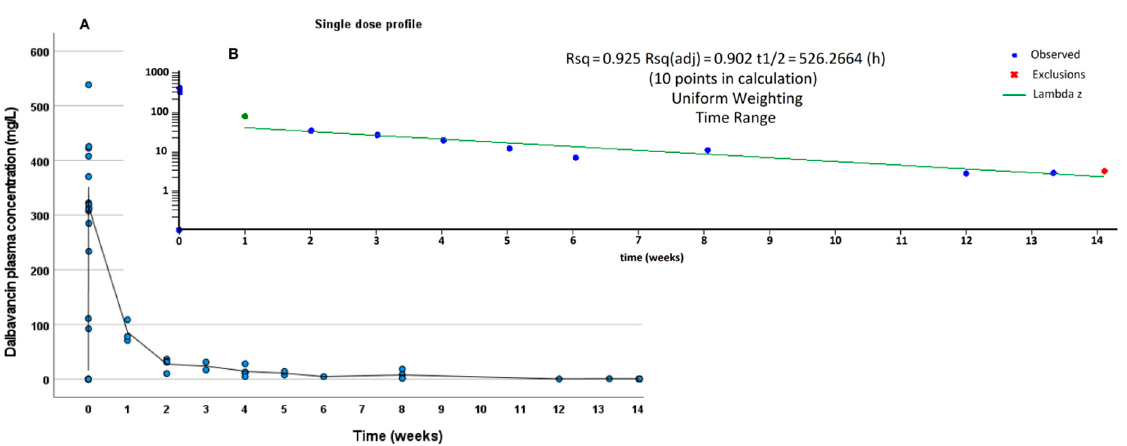
Figure 1. Summary of the mean PK data deriving from a single 1500 mg infusion of DBV (pooled in the first week) in linear-linear scale ( A ) and in log-linear scale ( B ). The blue line indicates the time range for the estimation of terminal λ z .